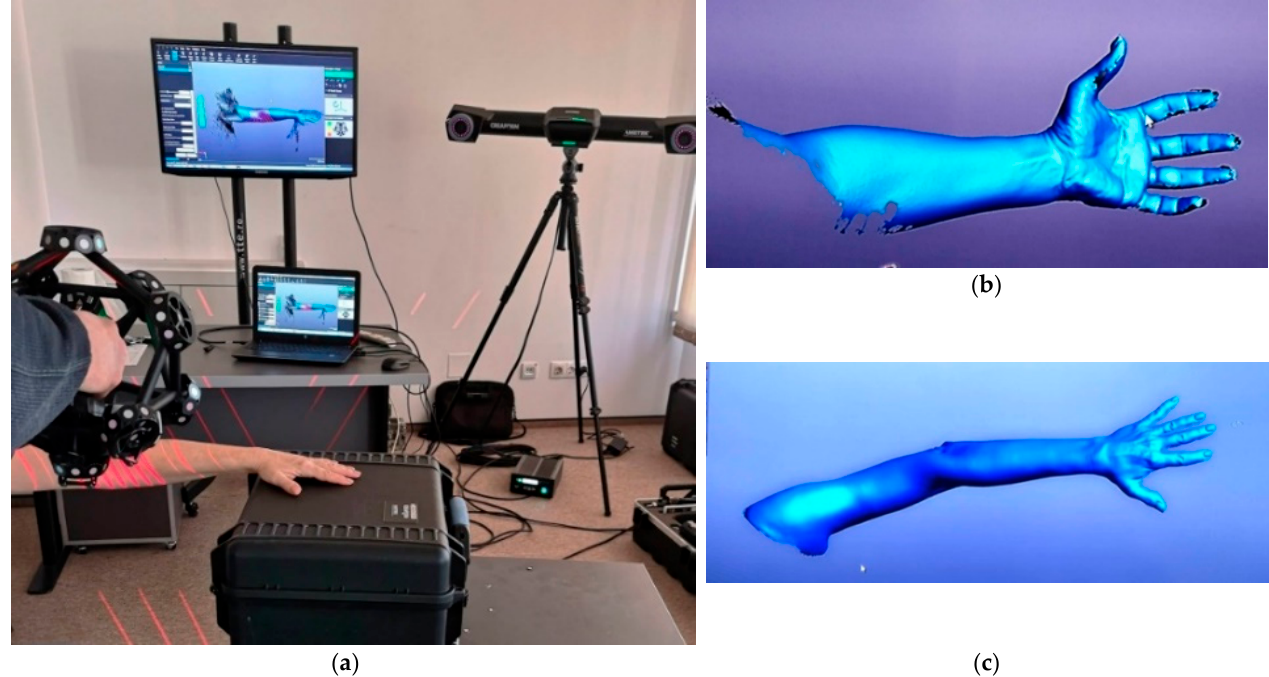
Figure 3. Reverse engineering technique for the real upper limb: ( a ) scanning process, ( b ) 3D scan surface—with errors, ( c ) 3D scan surface—accurate.